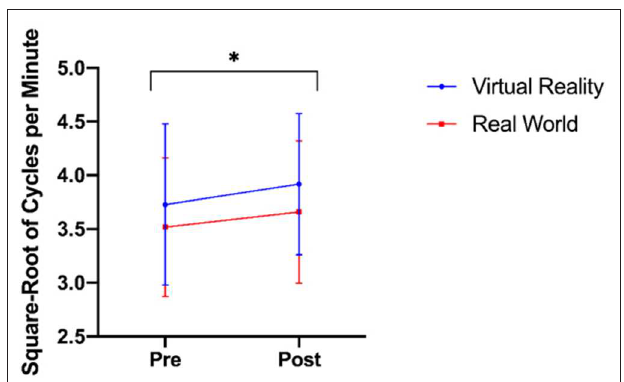
FIGURE 3 | Square-root transformed vergence facilities before and after training (* denotes p <